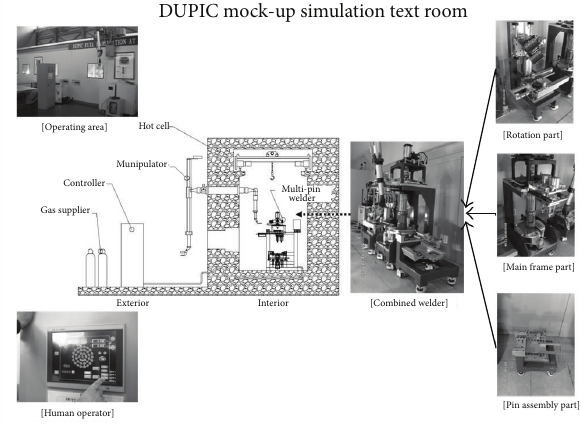
Figure13:Remoteweldingequipmentanditsoperationinmock-up